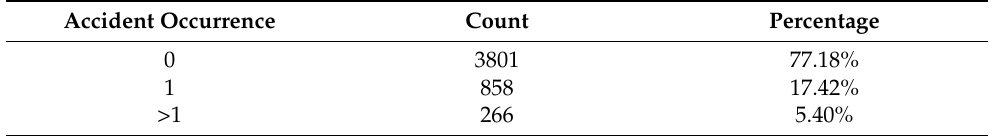
Table 9. Accident distribution.